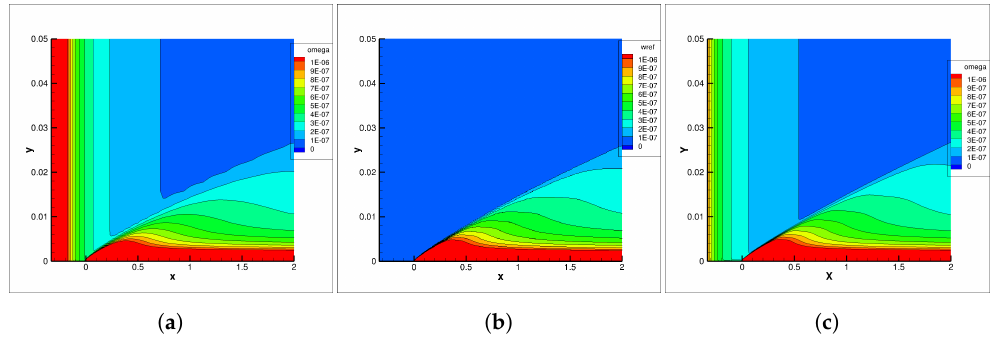
Figure 6. ω contours on flat plate using Shear Stress Transport turbulence model: ( a ) UNS3D-SEQ, ( b ) UNS3D-PAR, and ( c ) FUN3D [20]. Figure 7 shows the variation of dimensionless velocity u + = u / u ∗ , where u ∗ is the friction velocity, as a function of y + . A good agreement is observed among the results generated by UNS3D-SEQ, UNS3D-PAR, and CFL3D codes, for both the Spalart–Allmaras and Shear Stress Transport models.